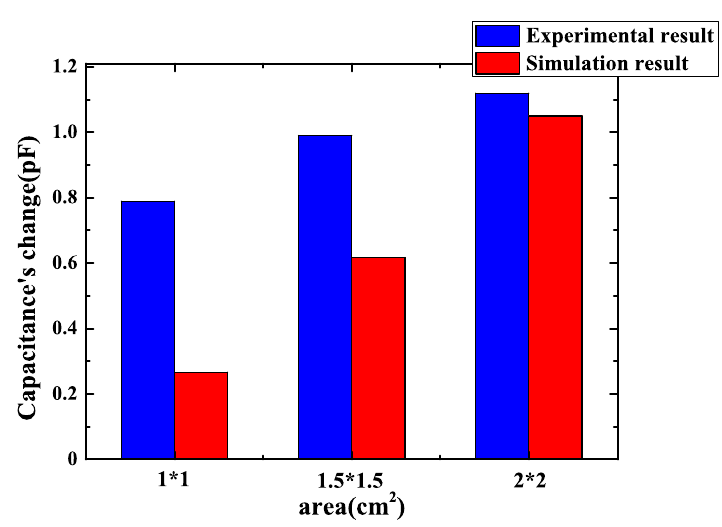
Figure 13. Experimental results of a spiral pattern sensor capacitance’s change with different areas.